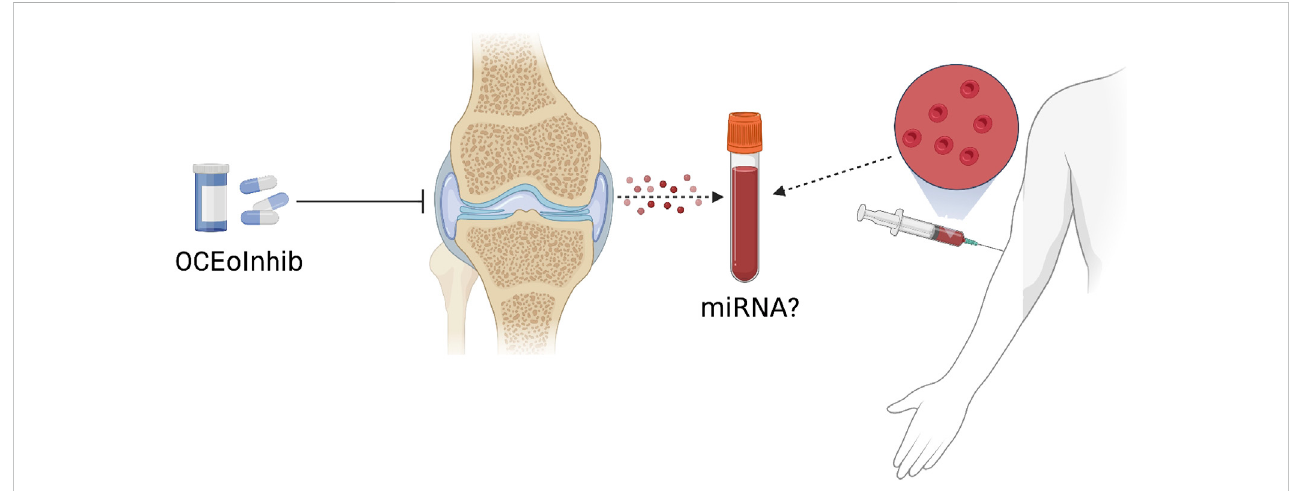
FIGURE 5 A new OC-targeted exosome inhibitor (OCEoInhib) to block Rab27-mediated OC exosome release. The measurement of OC miRNA in circulating exosomes could be used to diagnose illnesses and monitor their